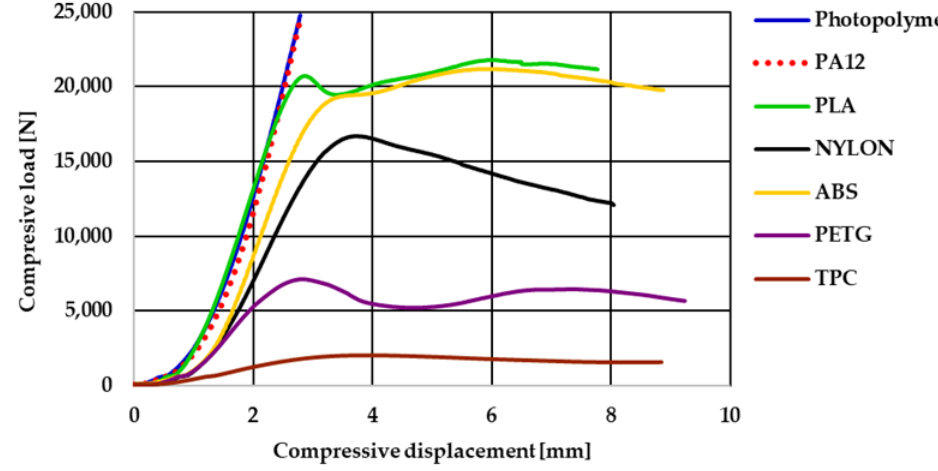
Figure 8. Heel compression test load–displacement curves.